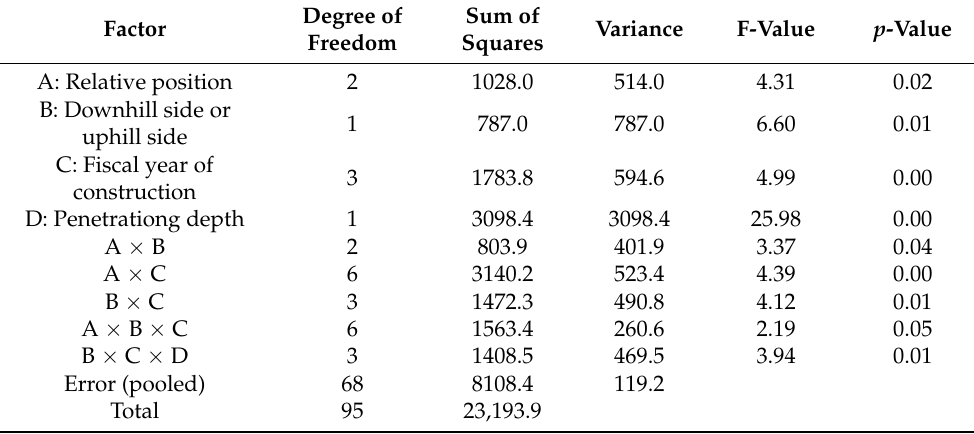
Figure 11. N d —values of Site 1 accompanied with thresholds. Table 4. ANOVA table of N d in Site